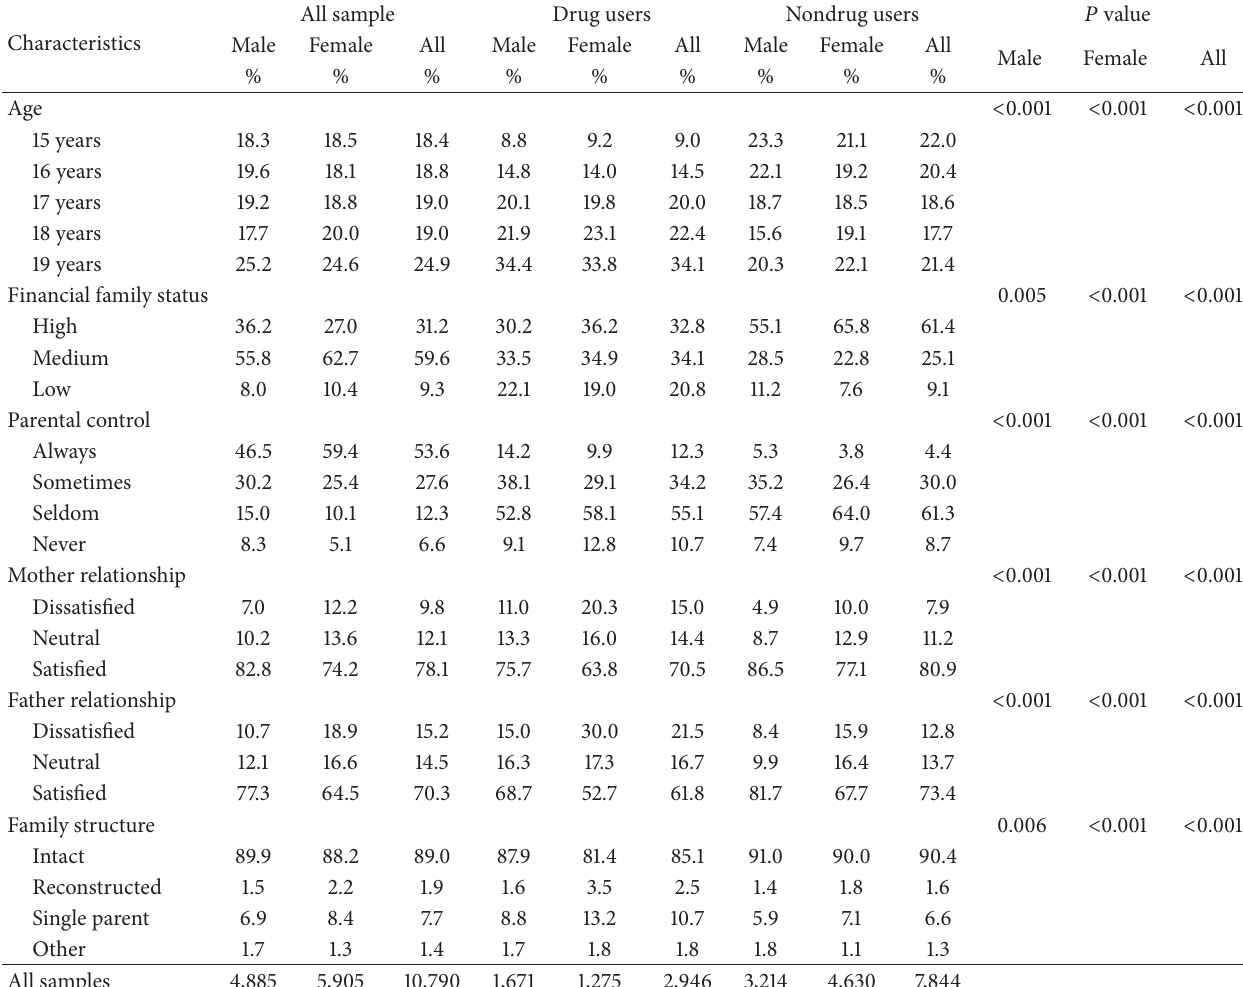
Table 2: Sample features and description of substance users and substance nonusers characterized by the main sociodemographic variables according to